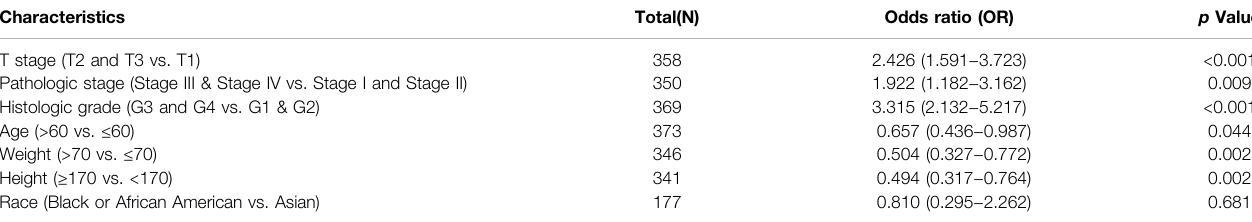
TABLE 1 | PAFAH1B3 expression associated with clinical pathological characteristics in LIHC (logistic regression). Characteristics Total(N) T stage (T2 and T3 vs. T1)